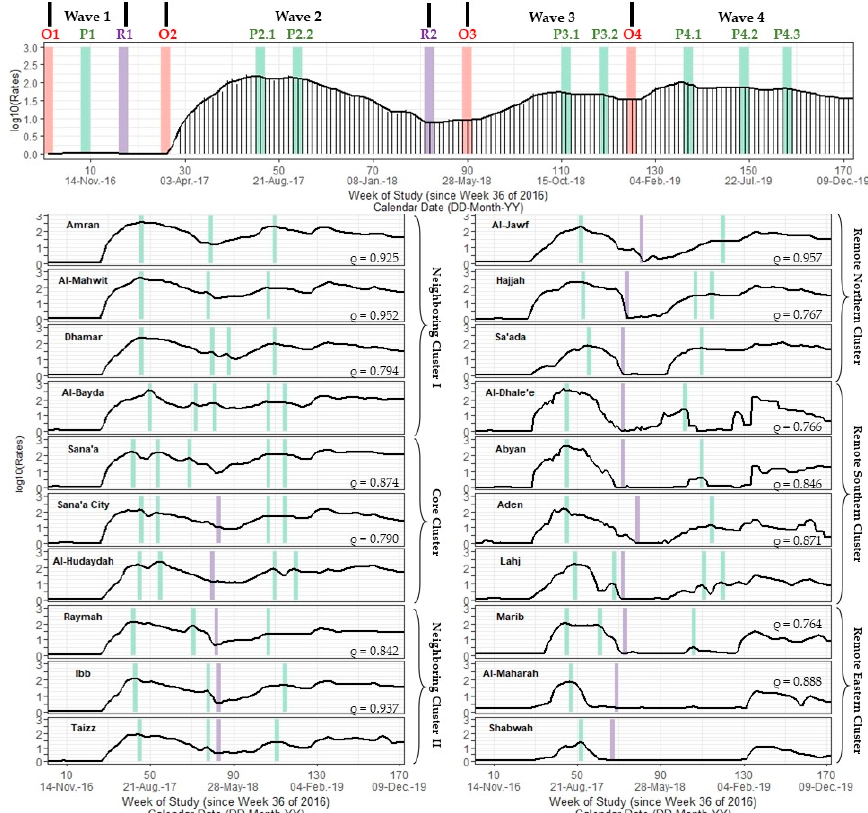
Figure 3. A multi-panel plot of the national Yemeni cholera outbreak signature and signatures for 20 Yemeni governorates (excludes the Hadramaut and Socotra island governorate). Top panel: the national signature includes a spike plot of log10-transformed cholera rates (in cases per 100,000 persons) and a time series line plot of smoothed rates calculated using Kolmogorov–Zurbenko adaptive filters from Week 36 (4–11 September) of 2016 through Week 52 (23–29 December) of 2019. Smoothed rates (laboratory-confirmed cholera cases per 100,000 persons) were estimated using the best performing smoother. Vertical red, green, and purple lines depict the timing of onset, peak, and resolution critical point (s), respectively, for each of the four outbreak waves. Bottom panels: governorate-level signatures are shown in two columns of stacked multi-panel time series plots that share a common vertical axis between columns (log10-transformed rates (cph)) and a common horizontal axis within columns (weeks since Week 36 of 2016, defined as study Week 0). Vertical green and purple bars depict the timing of the Wave 2 peak, Wave 2 resolution, and Wave 3 peak, which were important signature features for defining outbreak clusters. Spearman cross correlation estimates ( ρ ) are at lag 0 between adjacently reported governorates within the same cluster based on 172 weeks (all correlation coefficients are significant at α < 0.001). Data used to develop this visualization are reported in Table 1, Supplementary Table S1, and Supplementary Excel Table S3.